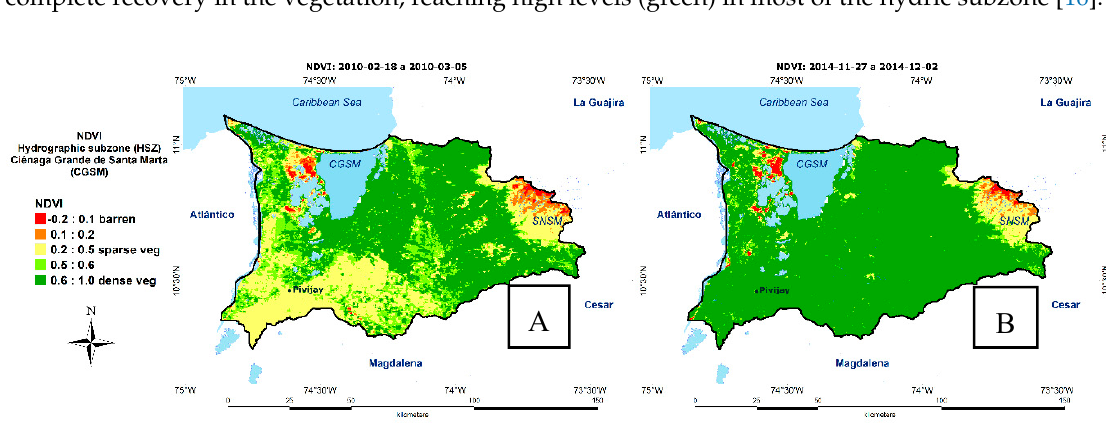
Figure 4. Vegetation classification according to the normalized difference vegetation index (NDVI) parameter. Zero indicates low quality or no vegetation, 1—excellent quality. Panel ( A ) and Panel ( B ) show the NDVI in the dry and rainy season, respectively.